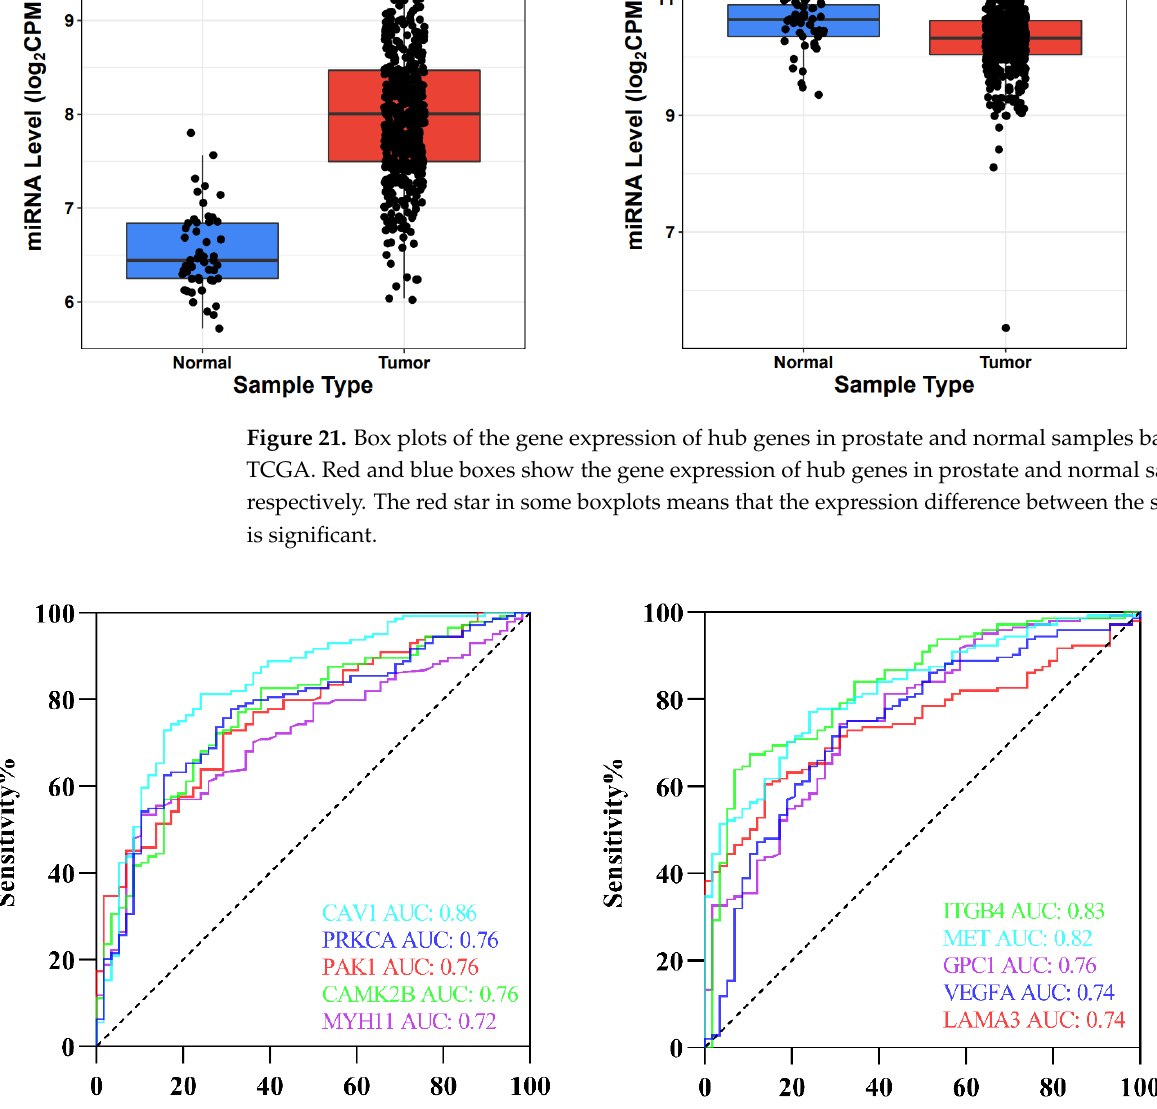
Figure 21. Box plots of the gene expression of hub genes in prostate and normal samples based on TCGA. Red and blue boxes show the gene expression of hub genes in prostate and normal samples, respectively. The red star in some boxplots means that the expression difference between the sam- ples is significant.